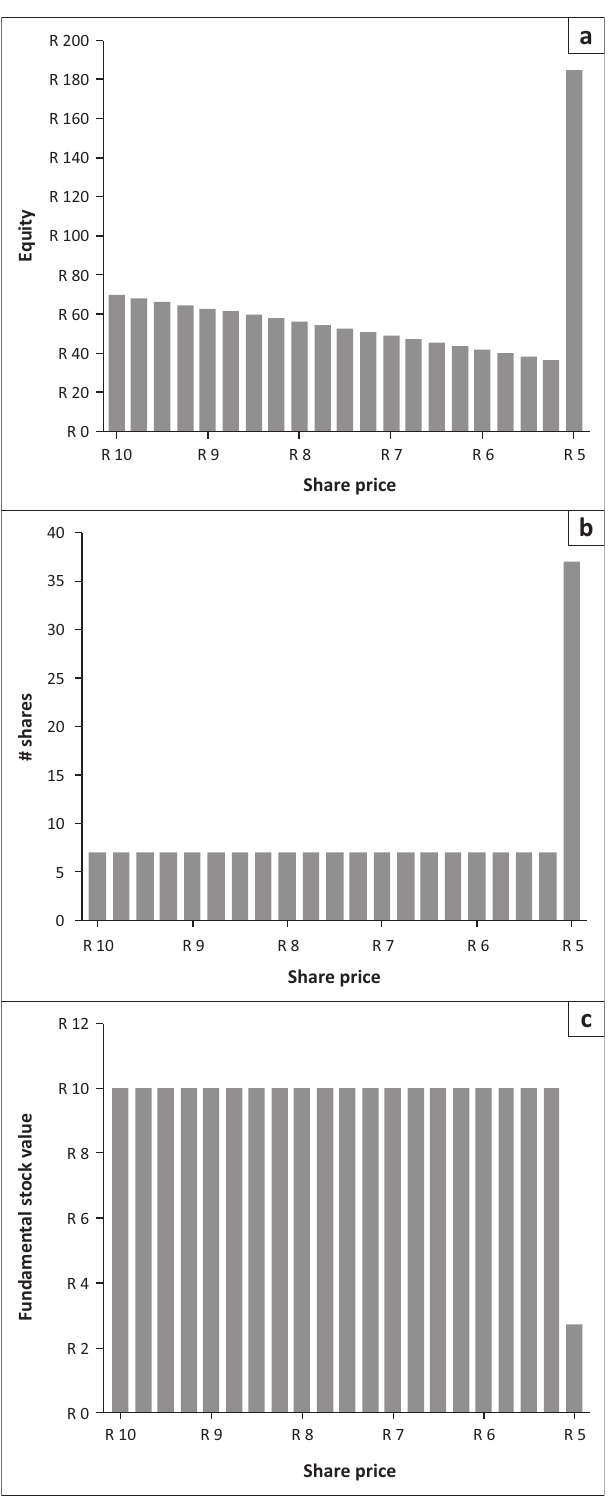
FIGURE 5: (a) Equity value, MV E , (b) number of shares in issue and (c) fundamental share value, S as a function of underlying share price. All descriptive parameters t as given in Table 3. c = t = p p